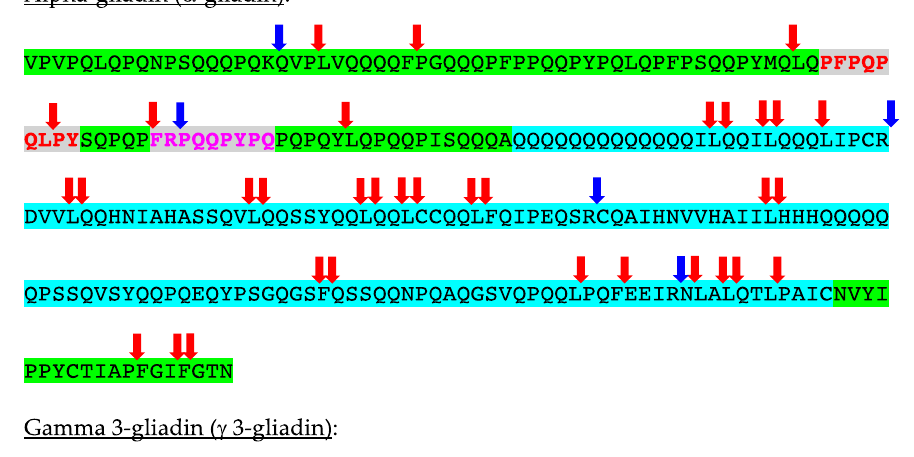
the disordered N ‐ terminal domain and the α‐ helical C ‐ terminal domain are colored yellow, green and violet purple, respectively. The four potential celiac peptides (1–4) are colored red. ( B ). Molec ‐